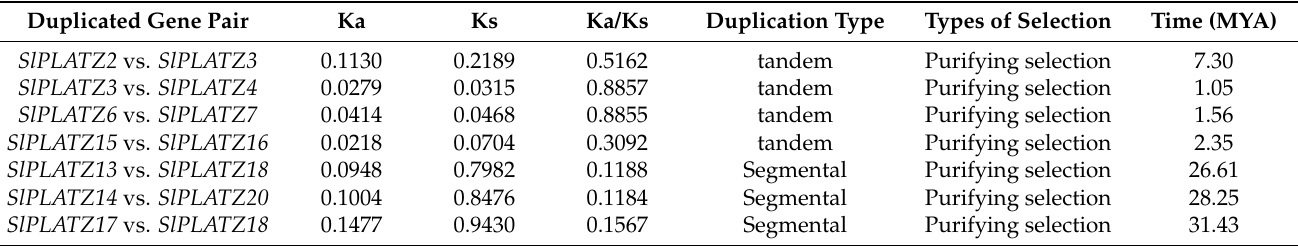
Table 2. Predicted Ka/Ks ratios of the duplicated SlPLATZ gene pairs along with their divergence